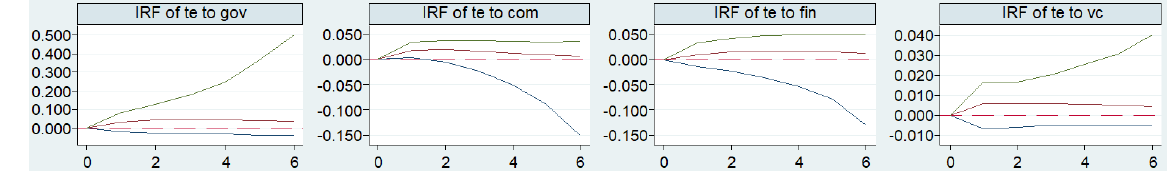
Figure 1. Impulse response of GTIE faced with the shock of technology and finance.